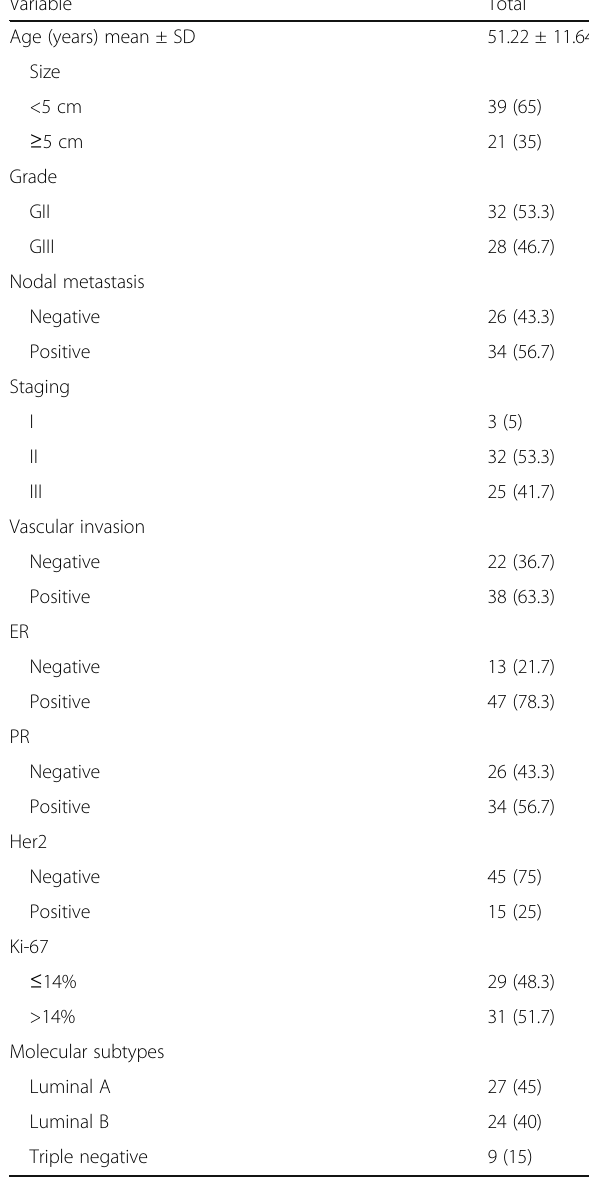
Table 1 Clinicopathological characteristics of the studied cases